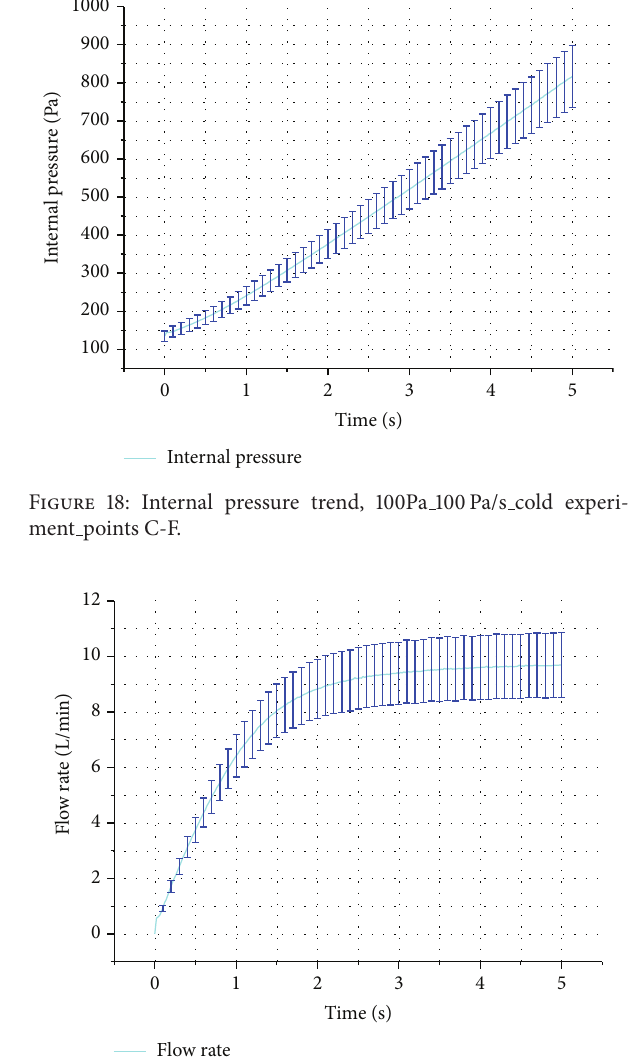
Figure 19: Flow rate trend, 100 Pa 100Pa/s cold experiment points